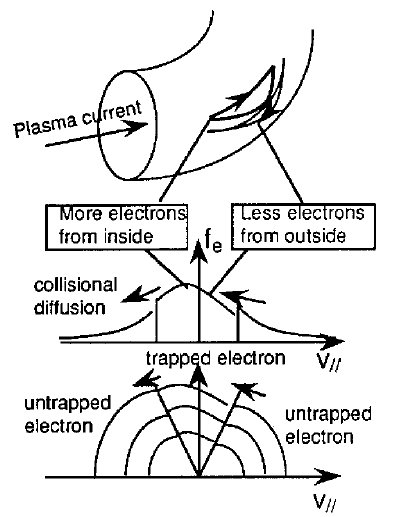
Figure 19. Sketch of the trapped electron orbits and distortion of one and two dimensional velocity distribution functions in a tokamak showing how collisional diffusion acts at trapped-passing boundary